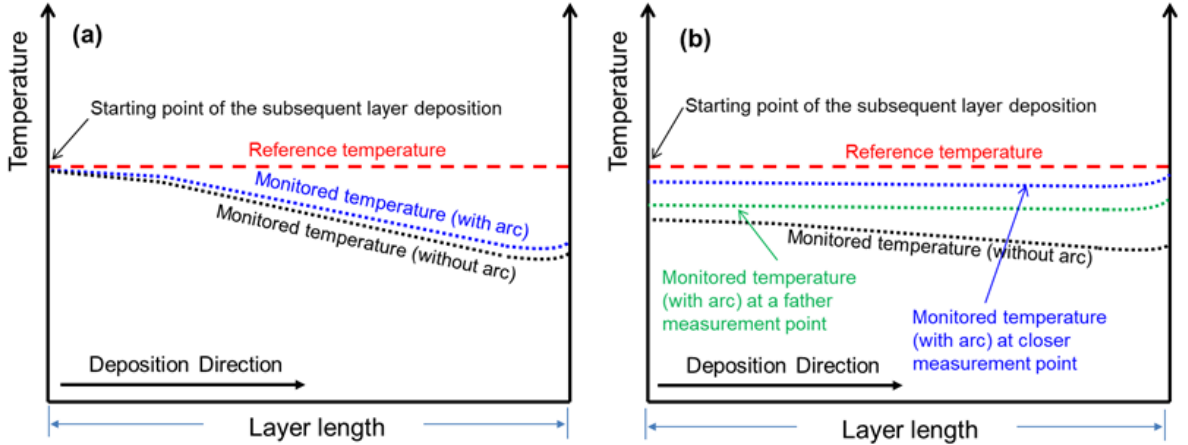
Figure 11. Qualitative model of the temperature profile along the wall length, in contrast to the reference temperature: ( a ) for the upper pyrometer strategy; ( b ) for the sideward pyrometer strat- egy.